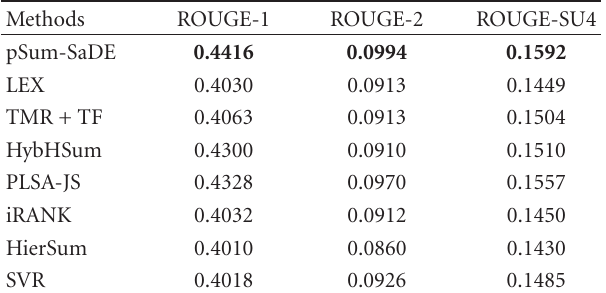
Table 3: Comparison with the three best systems on DUC